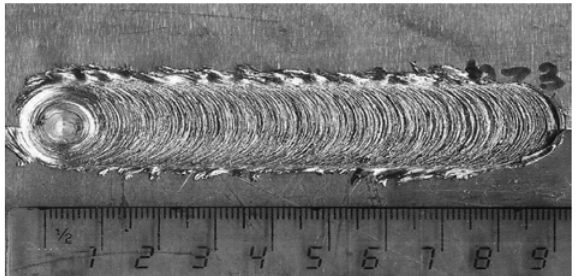
Figure 3: Weld coupon obtained at parameters, 300 to 400 rpm, 50 mm/min welding speed, zero IO, from FSW between 2024-T3 Al alloy and AZ31B-O Mg alloy plates.